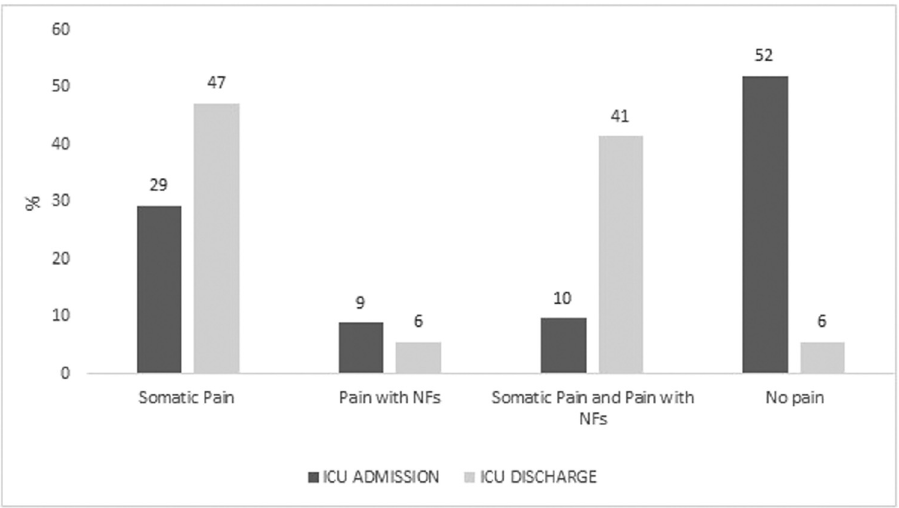
Figure 1: Neuropathic pain feature proportions by time.